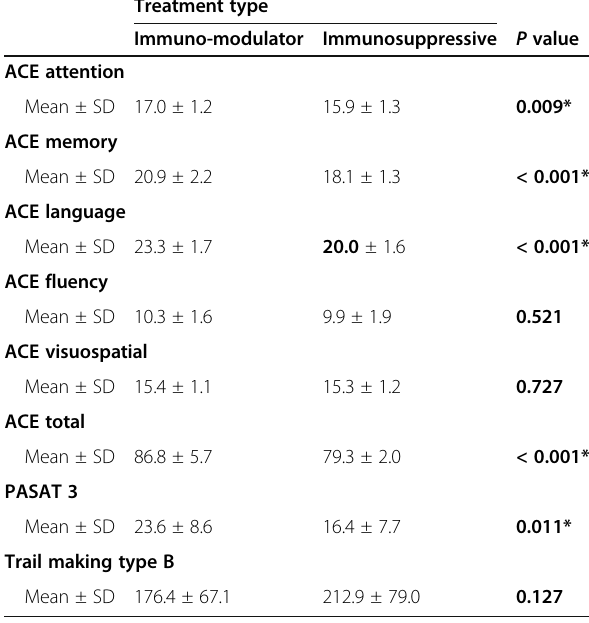
Table 6 Comparison of laboratory parameters and cognitive scale scores between MS patients distributed according to treatment